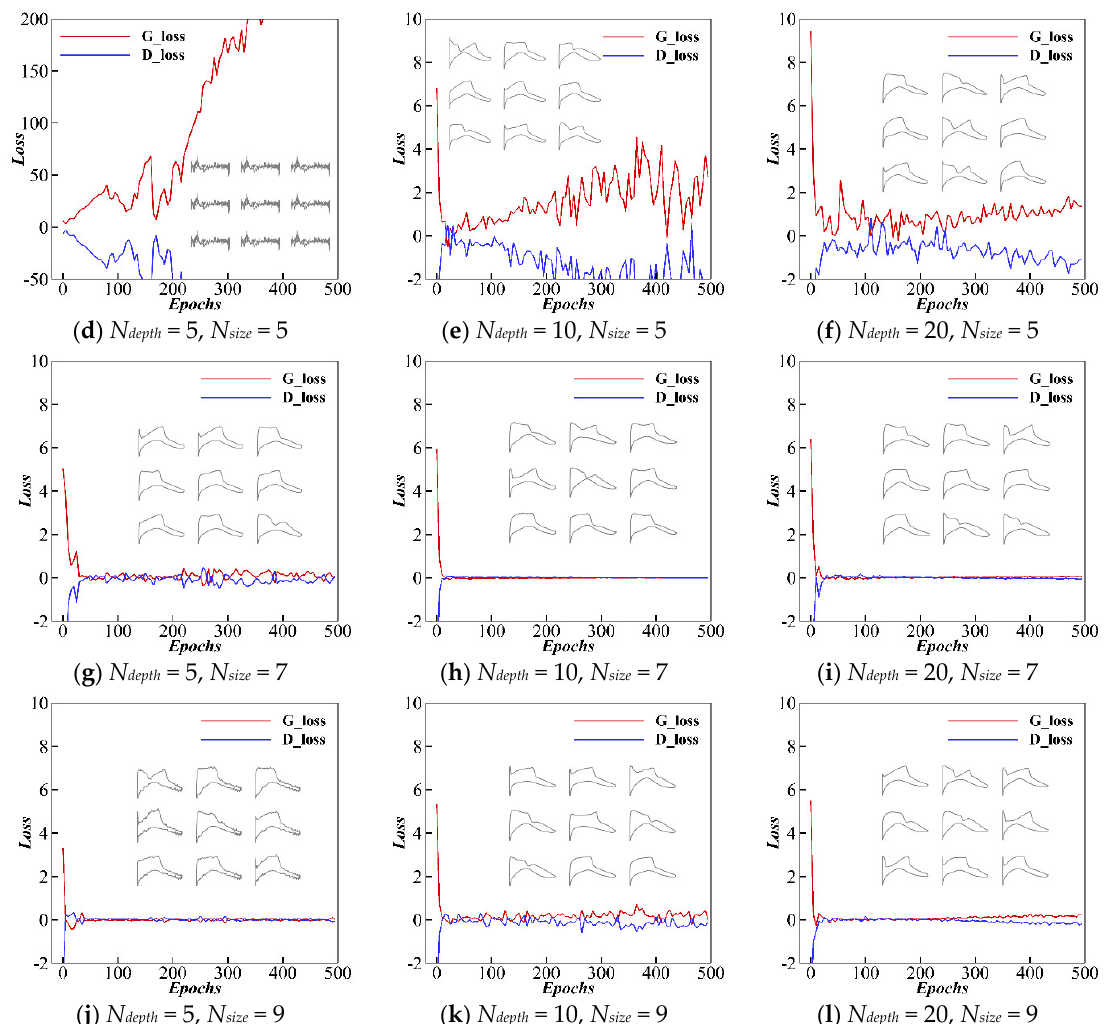
Figure 7. Converge histories of G and D for different N depth and N size